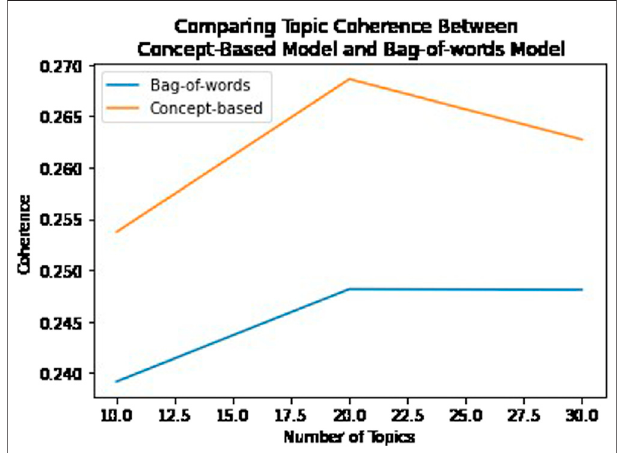
FIGURE 6 | Comparing topic coherence between the bag-of-words model and the concept-based model using the c_v measure.